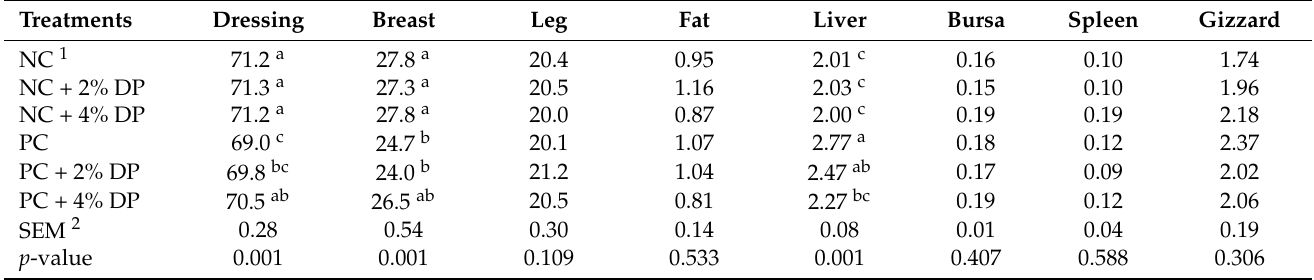
Table 3. Effect of adding two levels of date pits (DP) as aflatoxin adsorbent to aflatoxin B1 (AFB1)- contaminated diets on the relative weights (% of pre-slaughter weight) of carcass yields and internal organs in broilers at 30